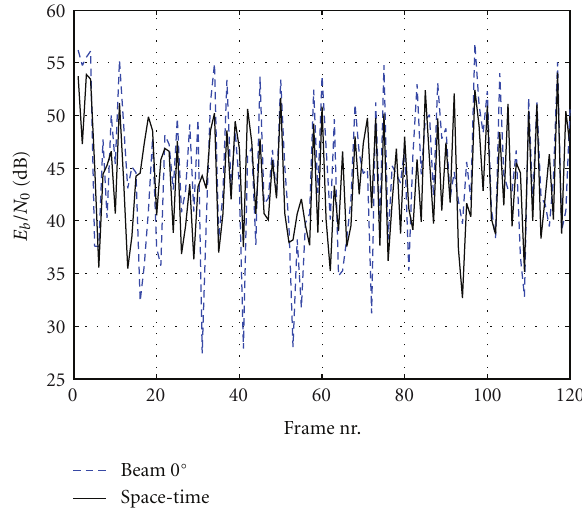
Figure 8: E b /N 0 in non-line-of-sight conditions, without receiver diversity (no MRC). NLoS transmissions performed at 20dB extra power compared to LoS